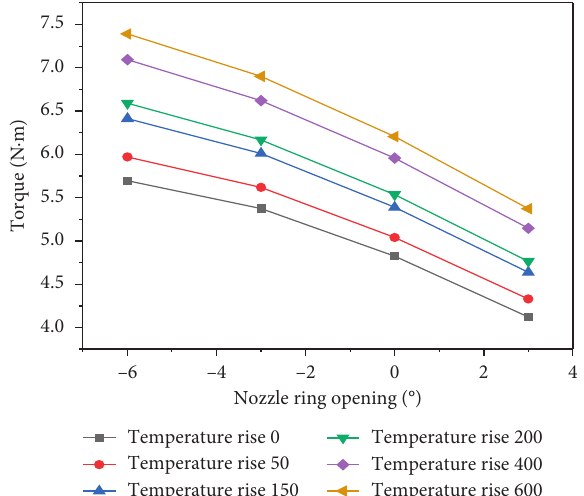
Figure 35: Relationship between opening and torque.